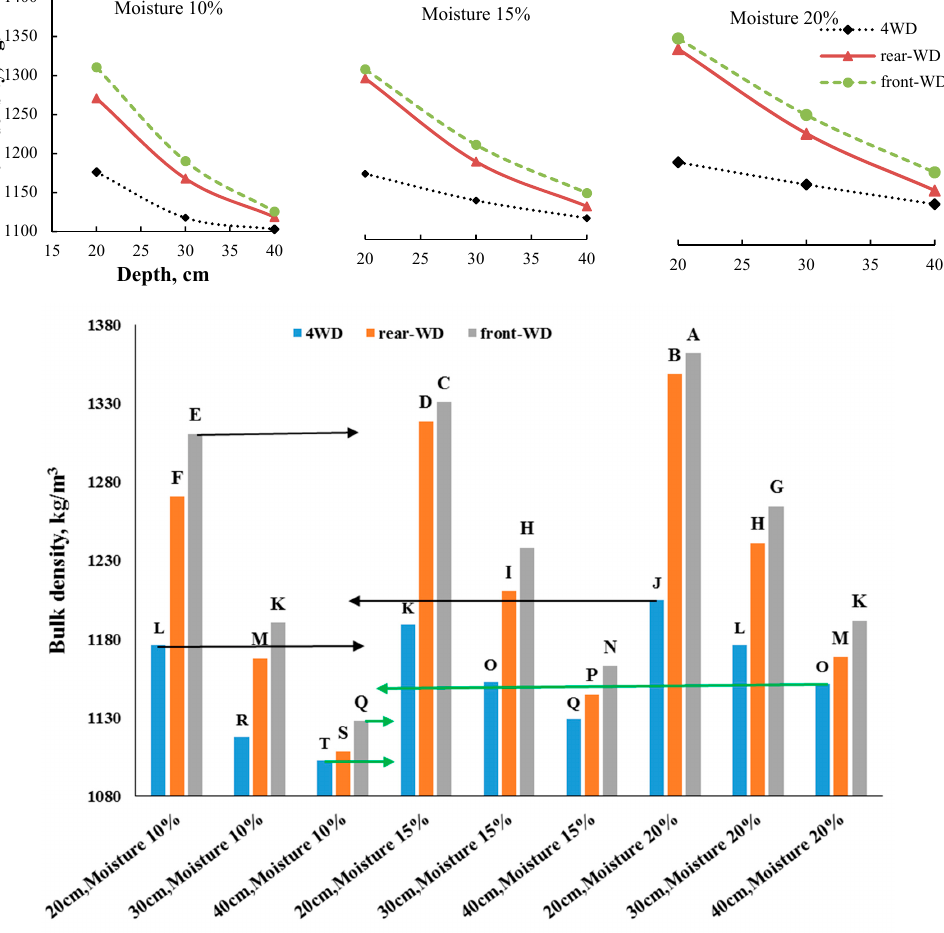
Figure 8. Changes of bulk density relative to the depth, moisture (d.b.) and driving system type. (different letters shows significant difference between treatments).